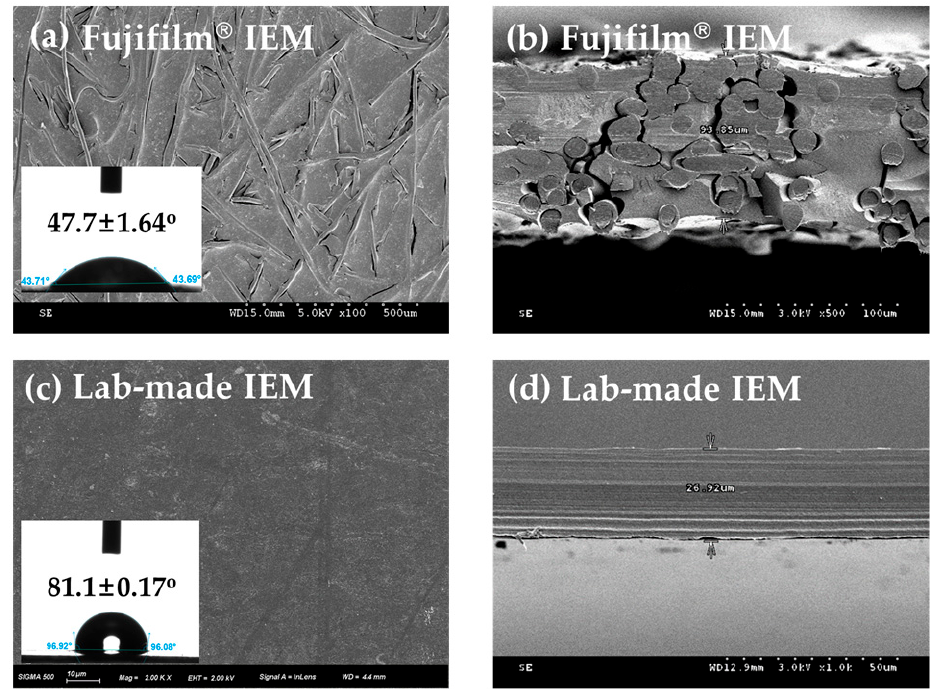
Figure 3. SEM images of ( a ) the top and ( b ) the cross-sectional view of the Fujifilm ® IEM and of ( c ) the top and ( d ) the cross-sectional view of the lab-made IEM. The insets in ( a , c ) are the contact angles on each IEM.